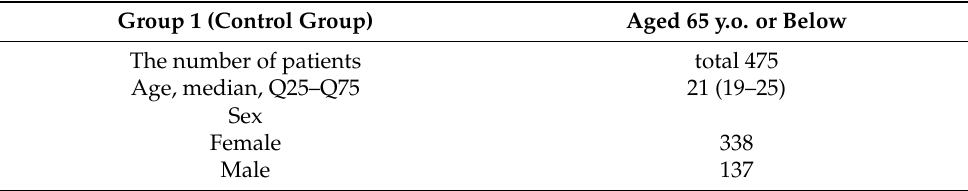
Table 18. Demographic data in Group 1 patients with COVID-19.